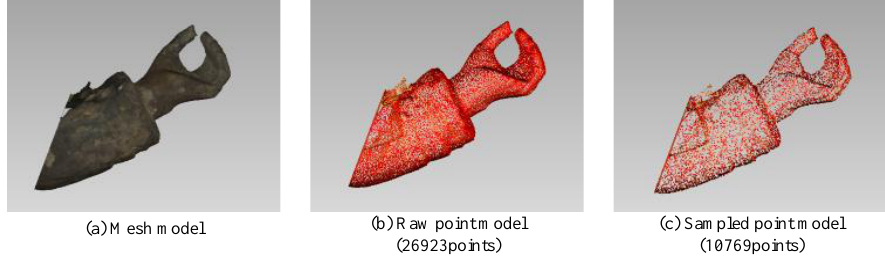
Figure 8. Sampling results of model 006192-Arm-38.